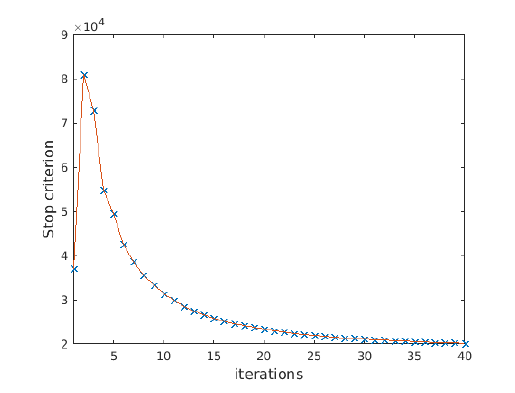
Figure 7. Convergence of PDFW